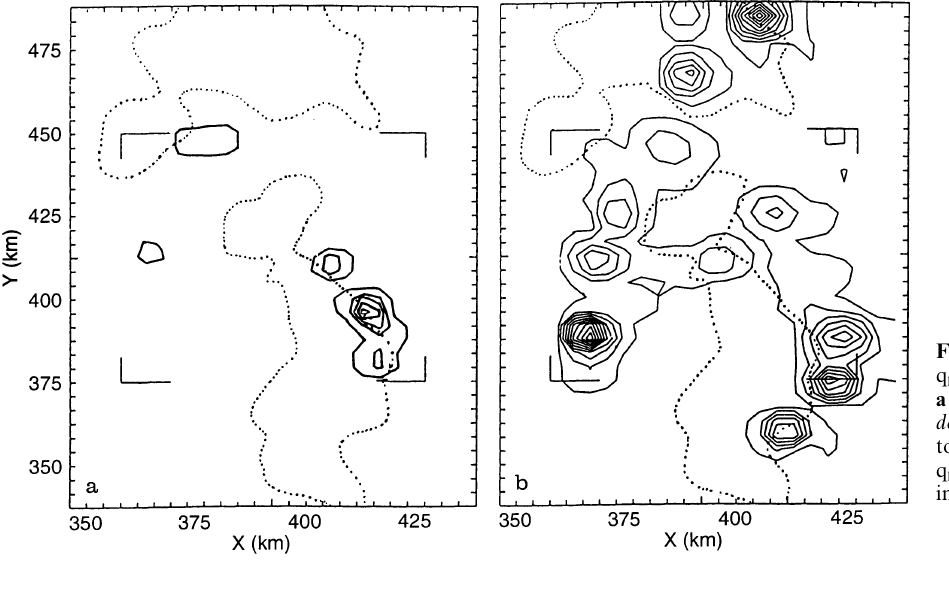
Fig. 6a, b. Rainwater mixing ratio, q (cid:82) , at 2 km height for SET II after a 165 min, and b 195 min. The dotted outline represents the 250 m topography contour line. The q (cid:82) contour intervals are 0.0625 g/kg in both